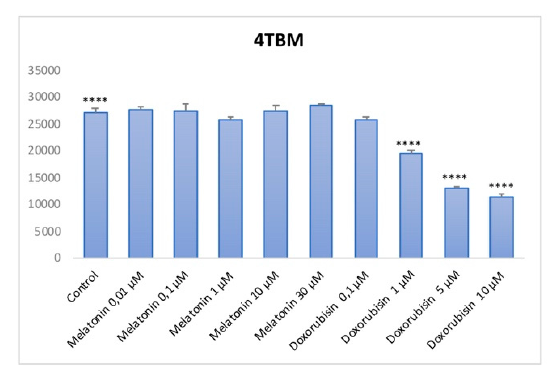
Figure 1. WST-1 cell proliferation assay after 72 h of incubation in normal medium (control), in treated with Melatonin and Doxorubicin (**** p <